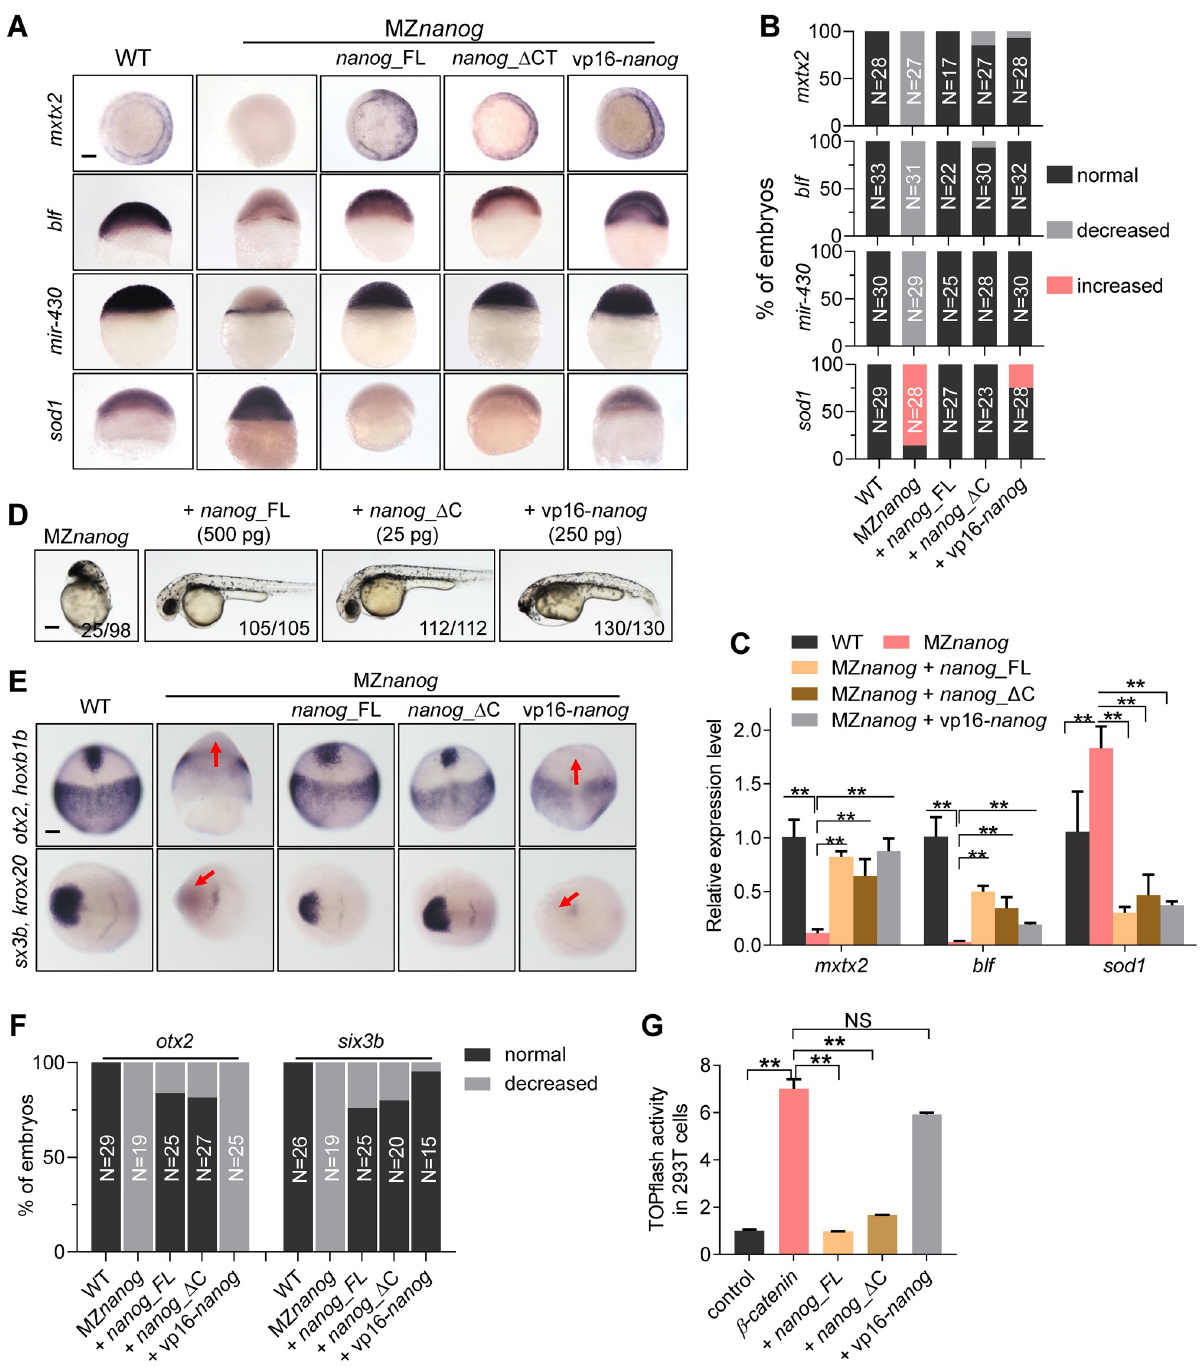
Fig 6. N-terminal of Nanog is required for its Wnt/ β -catenin repressive activity. (A) WISH analysis showing the expression of mesendoderm marker, mxtx2 , strictly zygotic gene, blf , and microRNA-430 precursor ( mir-430 ), and miR-430 target, sod1 in embryos of WT, MZ nanog , MZ nanog injected with nanog _FL, nanog _ Δ C, or vp16- nanog mRNA. Expression of mxtx2 , blf , and mir-430 was reduced, even absent, whereas expression of sod1 was significantly increased in MZ nanog embryos; overexpression of nanog _FL, nanog _ Δ C, or vp16- nanog restored the expression of mxtx2 , blf , and mir-430 and cleaned the expression of sod1 in MZ nanog embryos. mxtx2 , blf , and sod1 were detected at 6 hpf, and mir-430 was detected at 4 hpf. Scale bar, 100 μ m. (B) Statistical analysis of embryos in panel A. N represents analyzed embryo number. (C) Relative mRNA level of mxtx2 , blf , and sod1 in WT, Mz nanog , and the rescued embryos at 6 hpf examined by RT-qPCR analysis. Error bars, mean ± SD, �� P < 0.01. (D) Overexpression of nanog _FL, nanog _ Δ C, and vp16- nanog rescued the developmental defects of MZ nanog . Both of nanog _FL and nanog _ Δ C rescued embryos showed WT-like phenotype, whereas vp16- nanog rescued embryos still showed a forebrain defective phenotype. Phenotype was observed at 36 hpf. Scale bar,